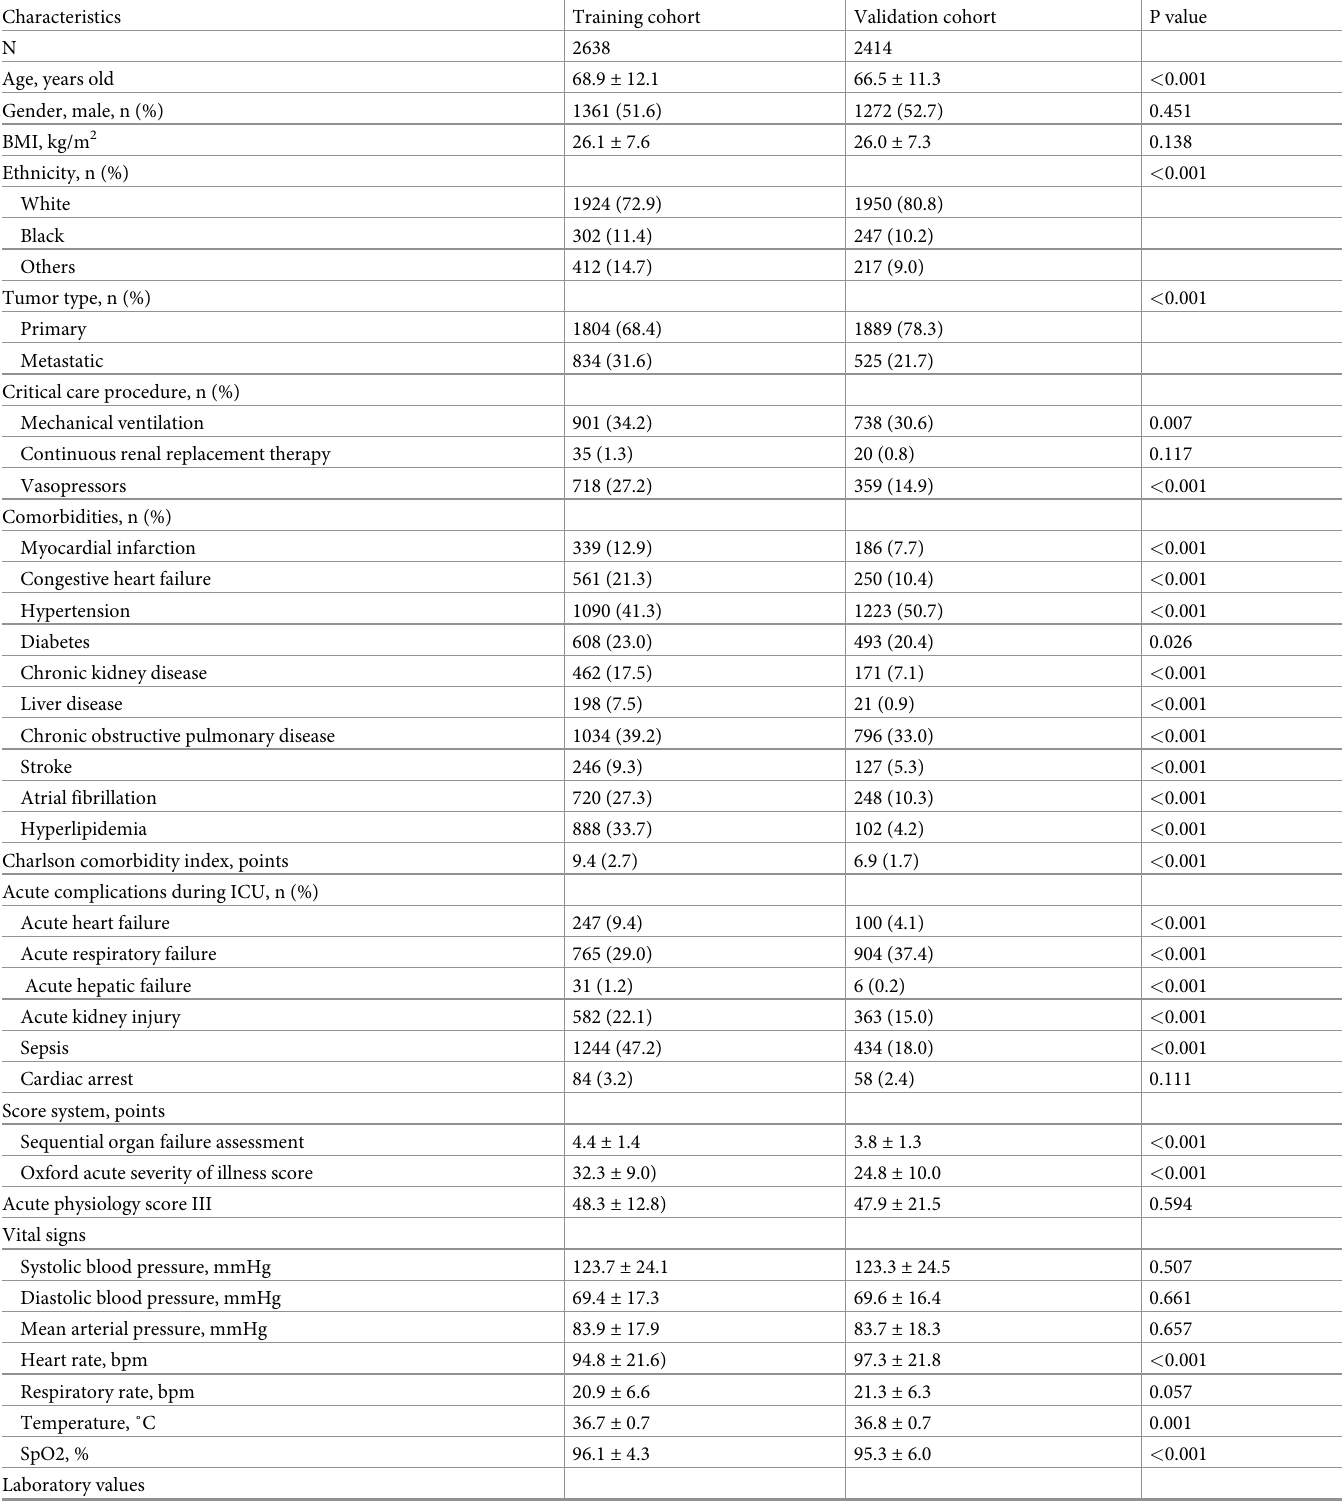
Table 1. Comparisons of baseline characteristics in all